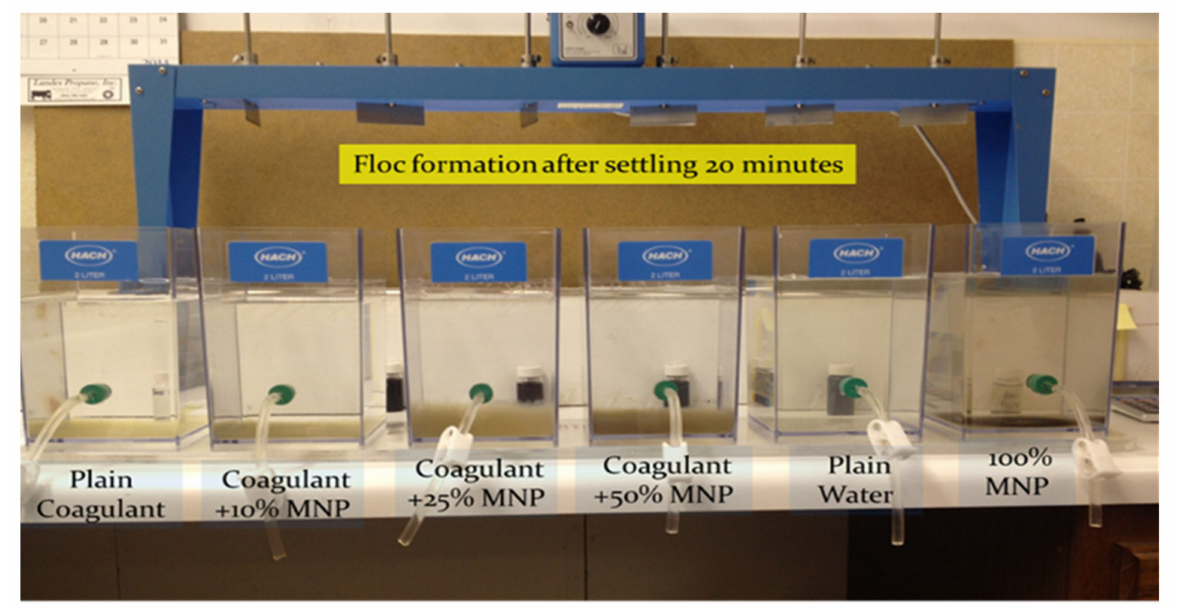
Figure 1. Pilot purification plant (jar